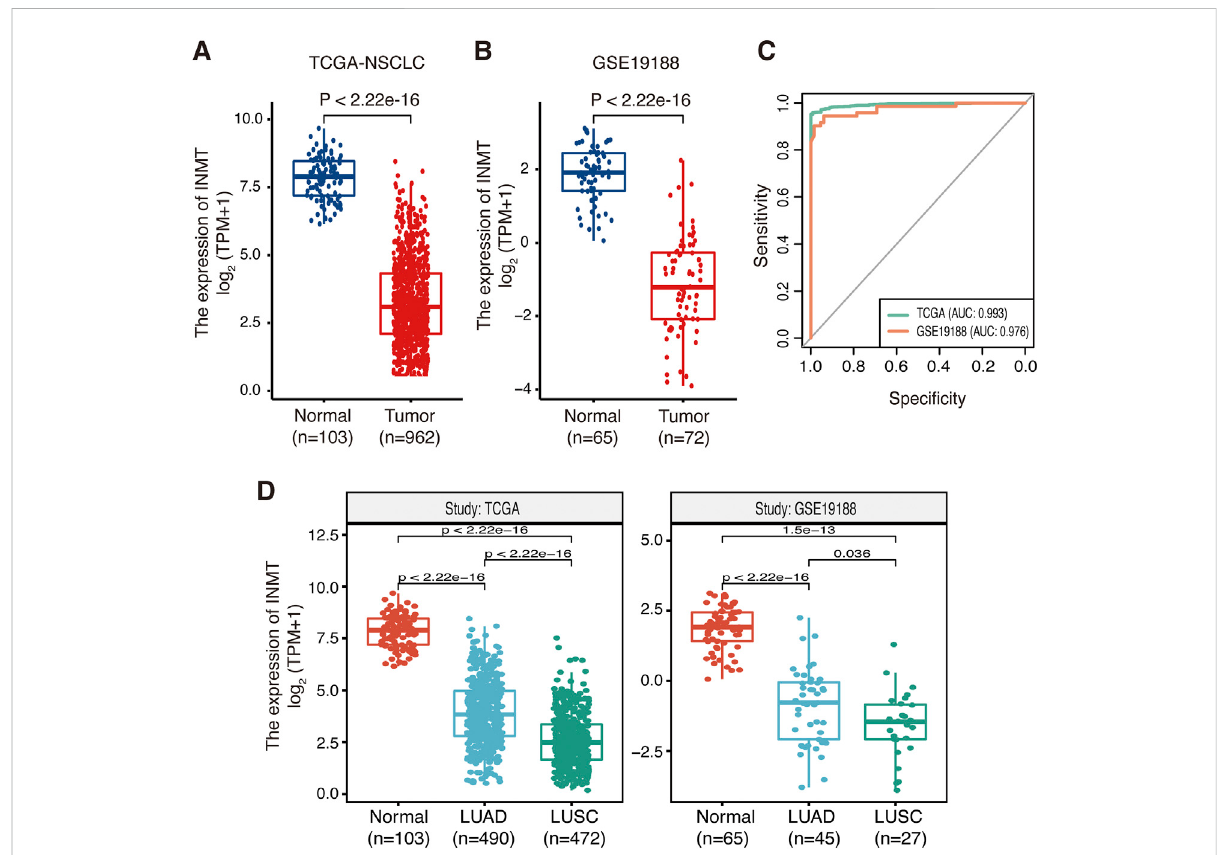
FIGURE 2 Expression of INMT in normal lung and NSCLC tissues. (A,B) Differential expression of INMT in normal lung and NSCLC tissues in TCGA dataset (A) and the GSE19188 dataset (B) . (C) Evaluation of the sensitivity and speci fi city of NSCLC diagnosis by ROC curves in TCGA dataset and the GSE19188dataset. (D) DifferentialexpressionofINMTinnormallung,LUAD,andLUSCtissuesinTCGAdataset(left)andtheGSE19188dataset(right), respectively. NSCLC, non-small-cell lung cancer; LUAD, lung adenocarcinoma; LUSC, lung squamous cell carcinoma; ROC, receiver operator characteristic; AUC, area under the curve; TPM, transcripts per million mapped